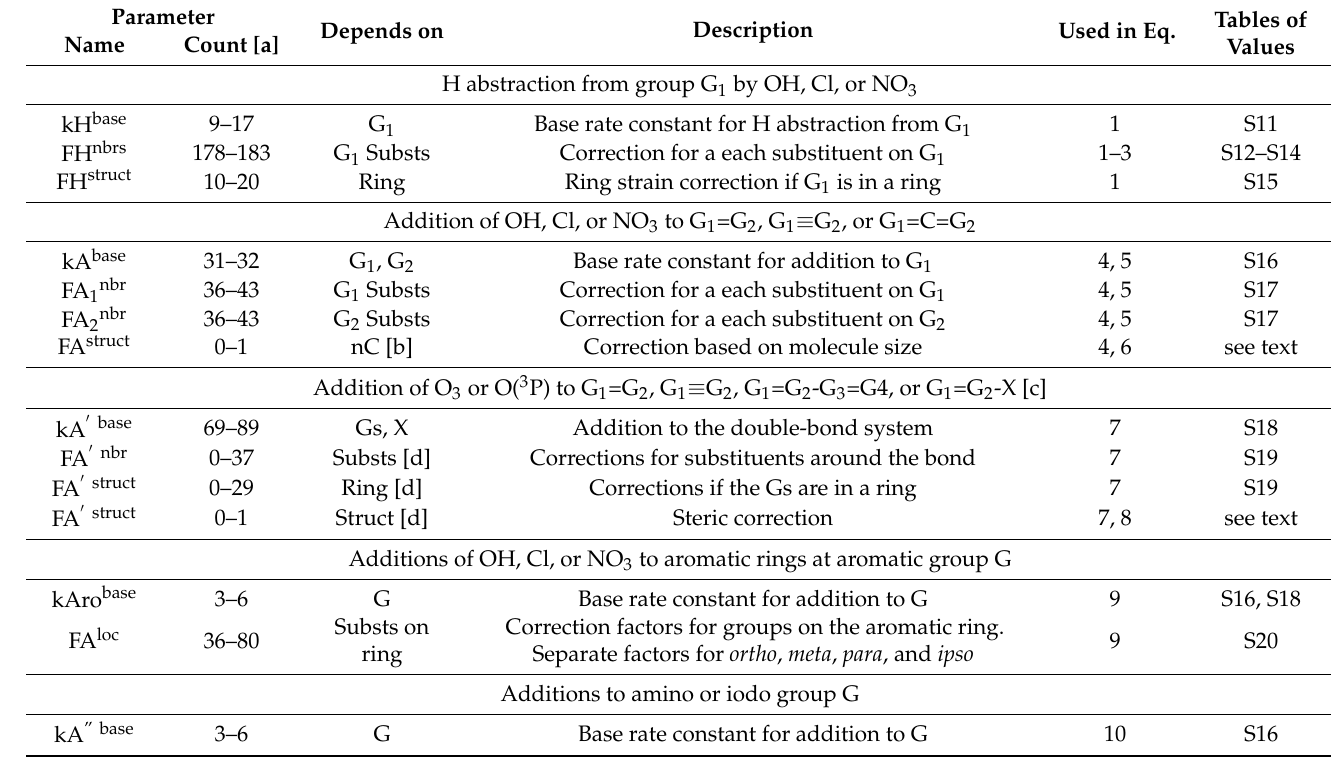
Table 3. Summary of parameters used for estimation of rate constants in this